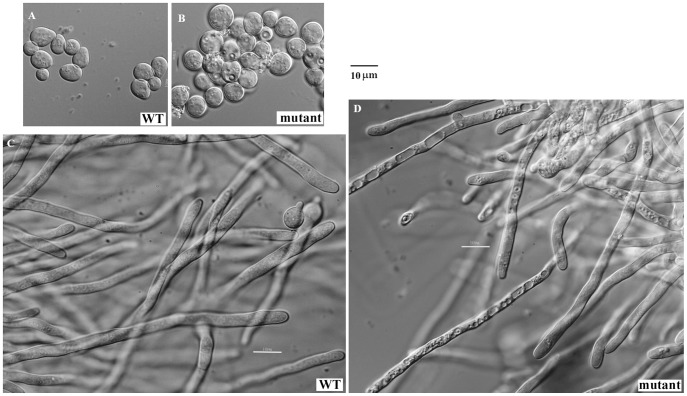
Differential interference contrast microscopy (DIC) of the mutant.2×108 conidia were inoculated into 200 ml liquid CM media and incubated at 37°C for 5 h (A and B) or 11 h (C and D) with shaking (200 rpm). The conidia and mycelia were collected and examined under the differential interference contrast microscope (DIC) (Olympus). The picture shows typical conidia (B) and mycelium (D) of the mutant strain.